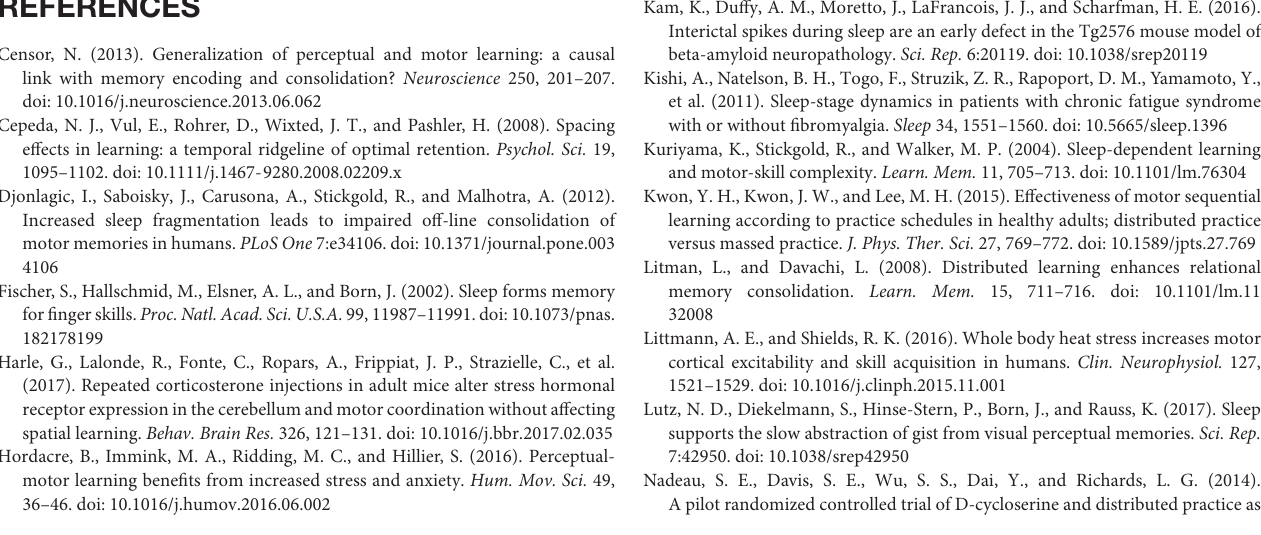
FIGURE S1 | Individual traces of rotarod performance during exclusive backward running. Gray lines show the individual performance traces and colored lines show the averaged performance for the naïve, ad libitum sleep, sleep disruption (SD), and natural wake